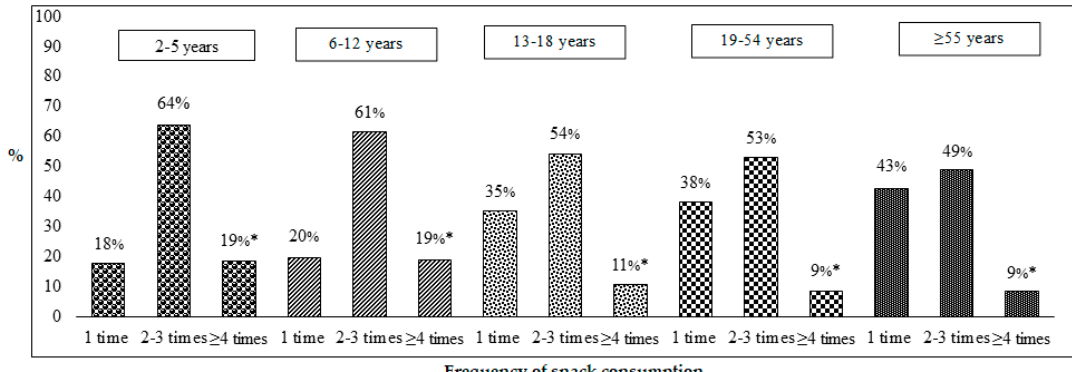
Figure 1. The frequency of snack consumption (%) among Canadians for five age groups 1 . Data source: 2015 Canadian Community Health Survey–Nutrition. * Significant difference in the number of occasions of snack consumption within the specific age group. 1 All data were weighted and bootstrapped to the Canadian population. 2–5 years: n = 1,181,823; 6–12 years: n = 2,407,637; 13–18 years: n = 2,228,356; 19–54 years: n = 12,768,195; 55+ years: n = 8,310,789.